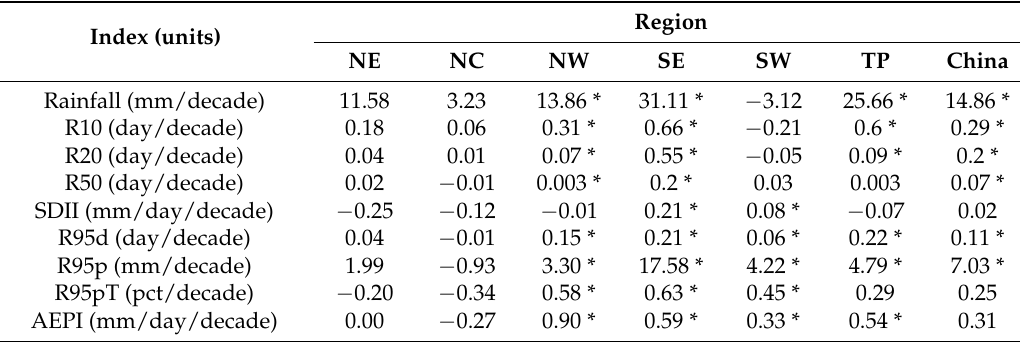
Table 4. Trends in extreme precipitation indices in the six regions of